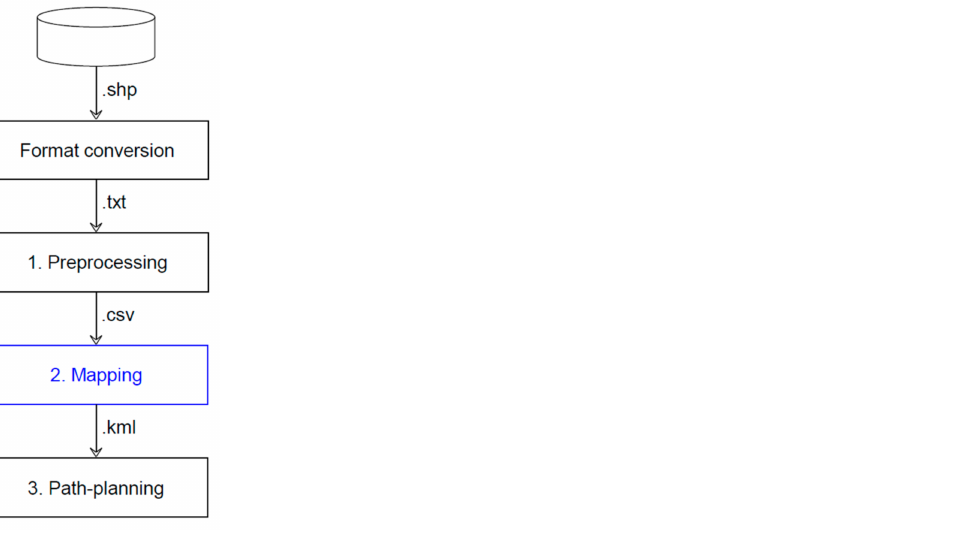
Figure 9. High-level flowchart outlining key stages in vector map generation. Table 11. Three stages of vector map